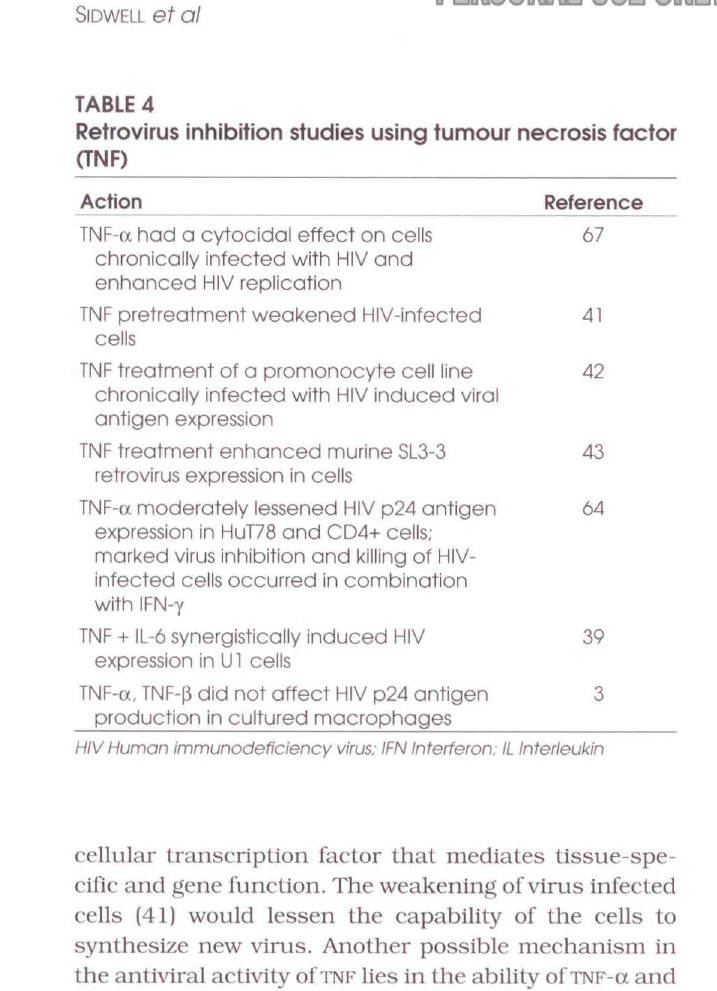
Retrovirus inhibition studies using tumour necrosis